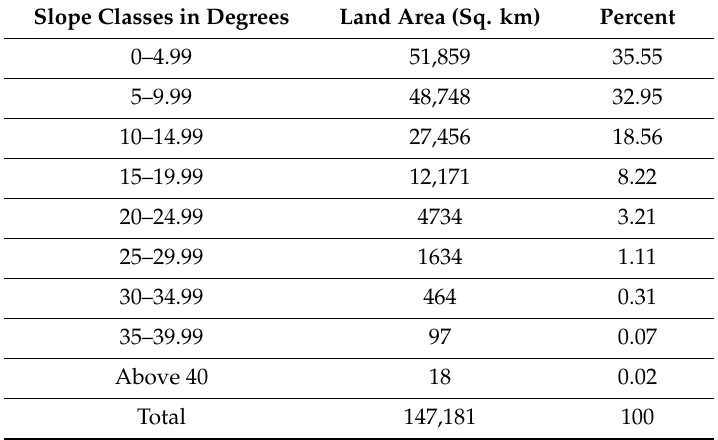
Table 1. Nepal’s landscape by slope